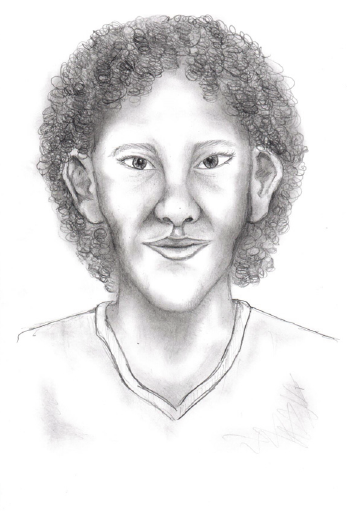
Figure 1: Artist rendition of the facial features associated with Alagille